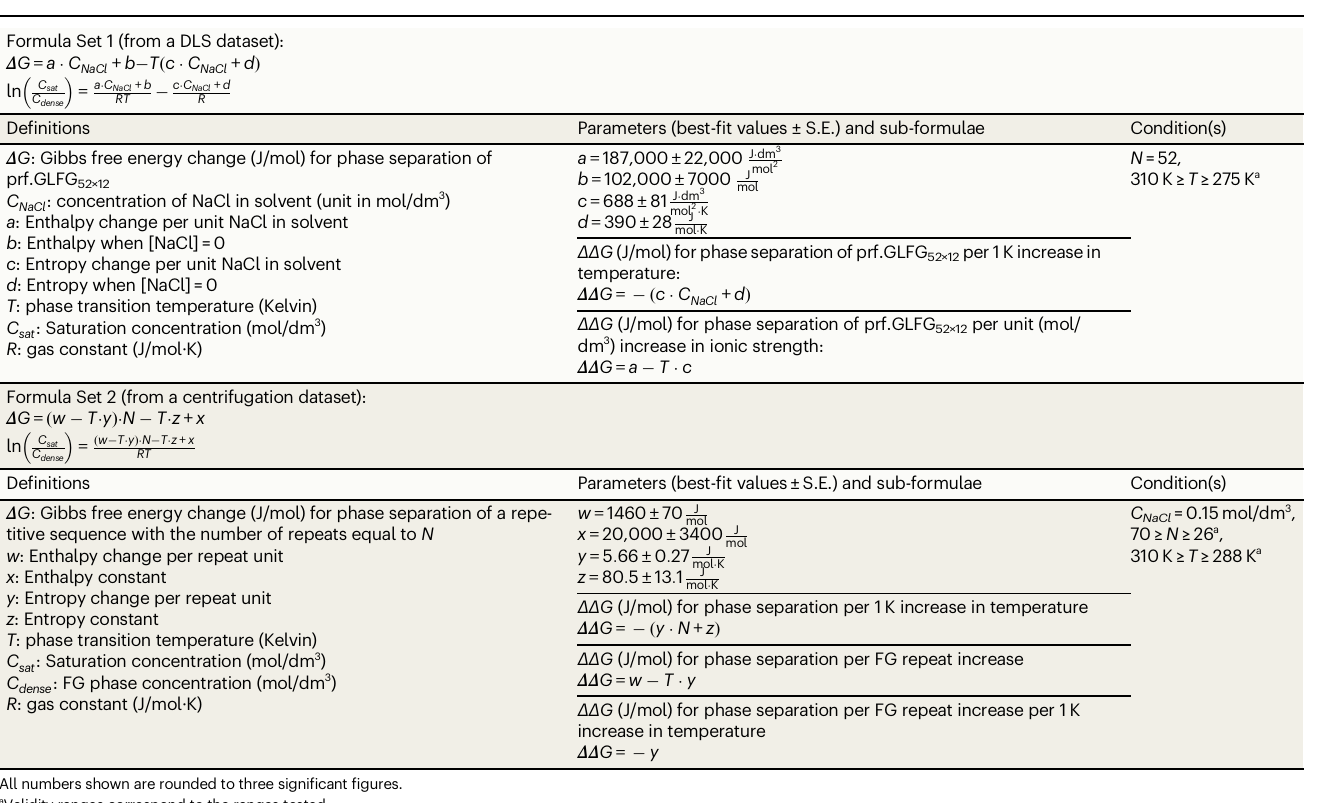
Table 2 | Quantities obtained either by calculations based on formulae shown in Table 1 or by fi tting the datasets speci fi ed Quantity Input values a /conditions Formulae/dataset Output value ΔΔ G − 255J/mol Partition coef fi cient measurements part . per FG repeat increase C NaCl =0.15mol/dm 3 , T =294K (Fig. 1d, e) T =294K −